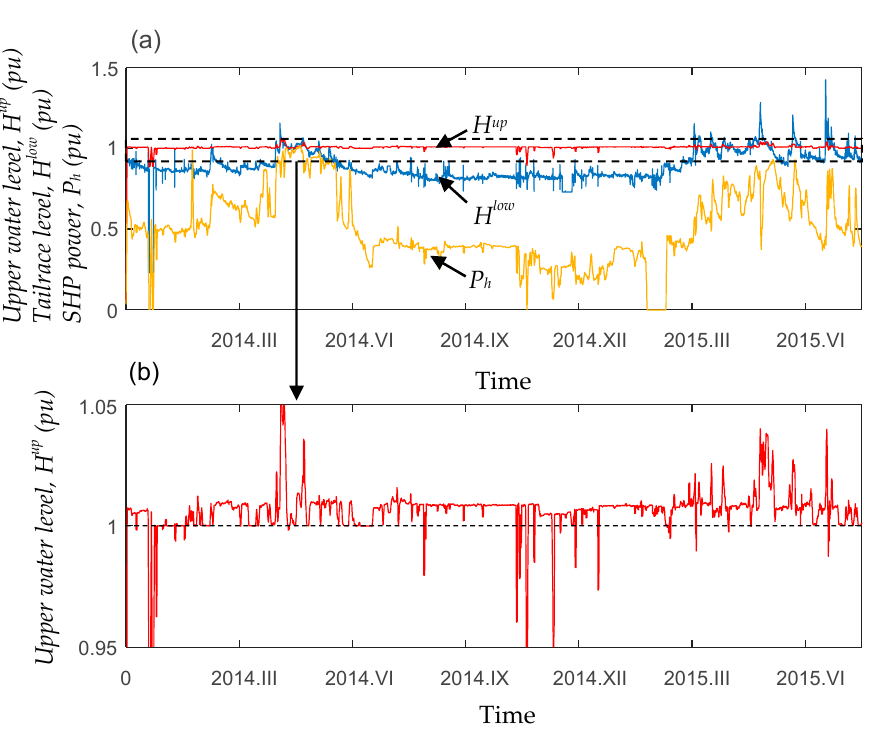
Figure 12. Real waveforms of ( a ) SHP power, upper and tailrace water levels, and ( b ) upper water level in a twenty-month period.